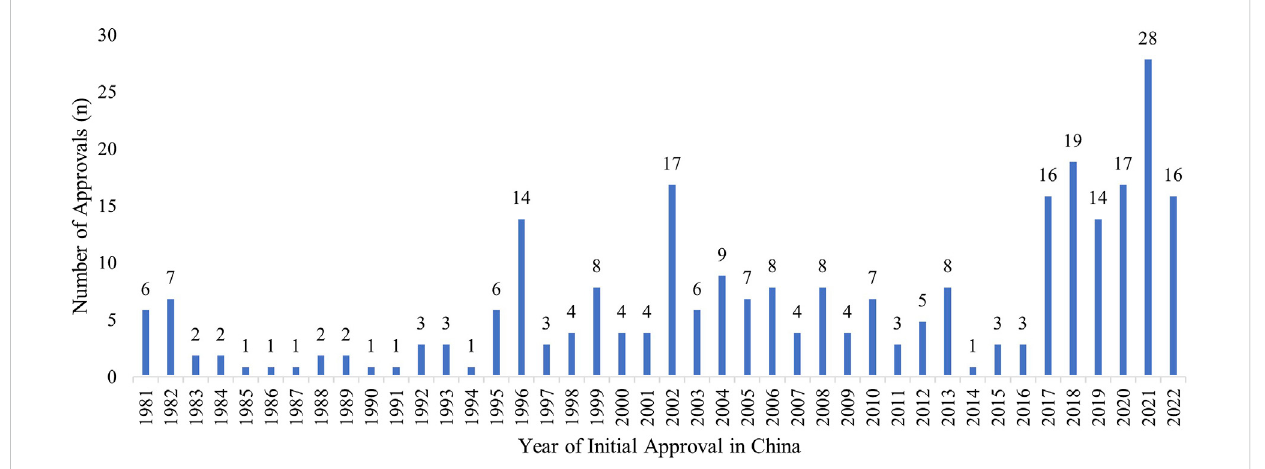
FIGURE 1 Initial Marketing Approvals in China of the FDA-approved Orphan Drugs. The distribution of initial marketing approvals in China of the 279 FDA- designated orphan drugs, up to May 2022, including drugs marketed for non-orphan indications in China prior to receiving an orphan indication by the